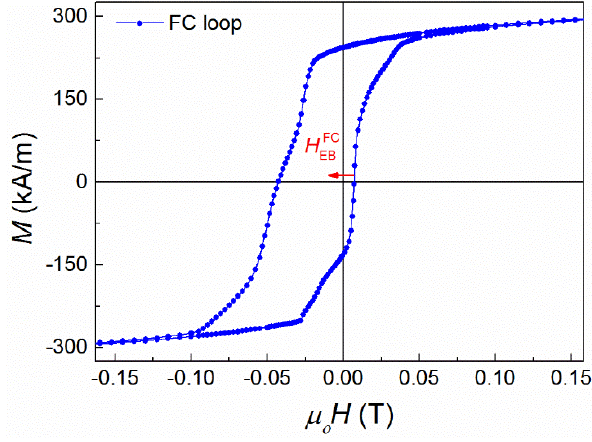
Figure 1. Field cooling (FC) hysteresis loop of the Ni–Co–Mn–Sn film at 5 K, cooled from 400 K under the influence of a cooling field of 1 T.